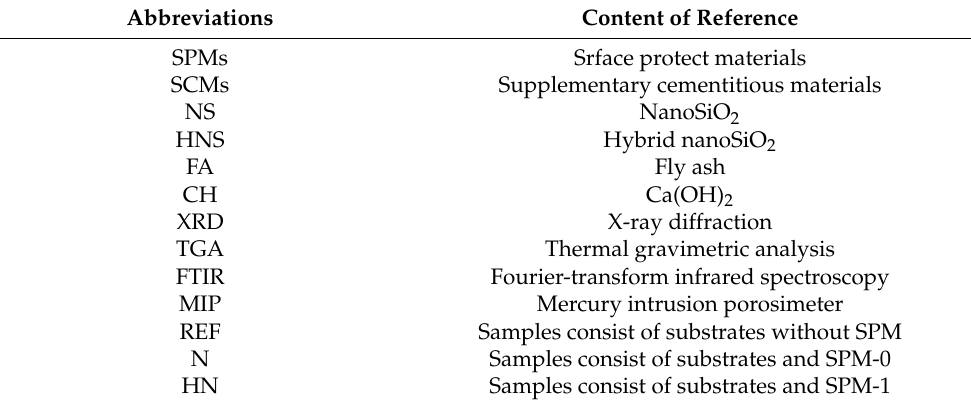
Table 5. Explanations of abbreviations.